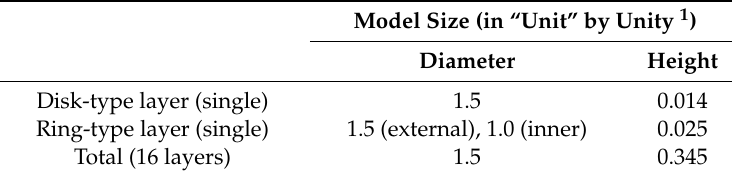
Figure 1. Layered cylinder model for simulated pottery. Table 1. Initial state of layered cylinder model.